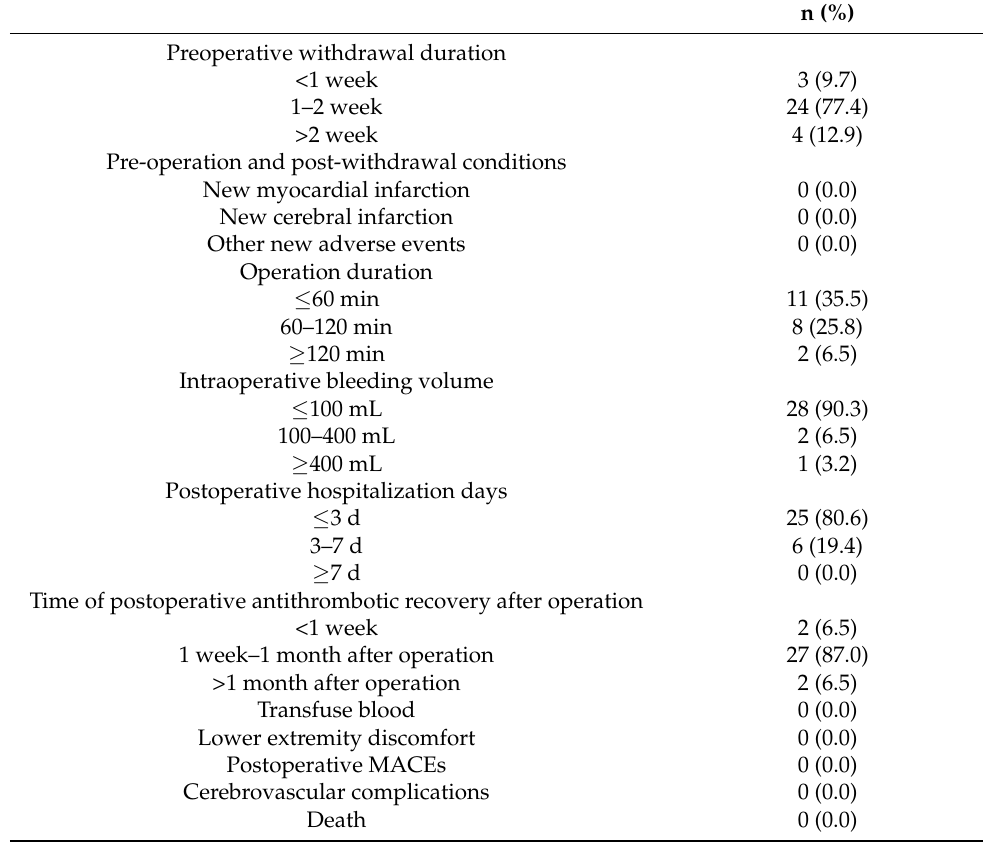
Table 3. Perioperative conditions and clinical outcomes of TURP.